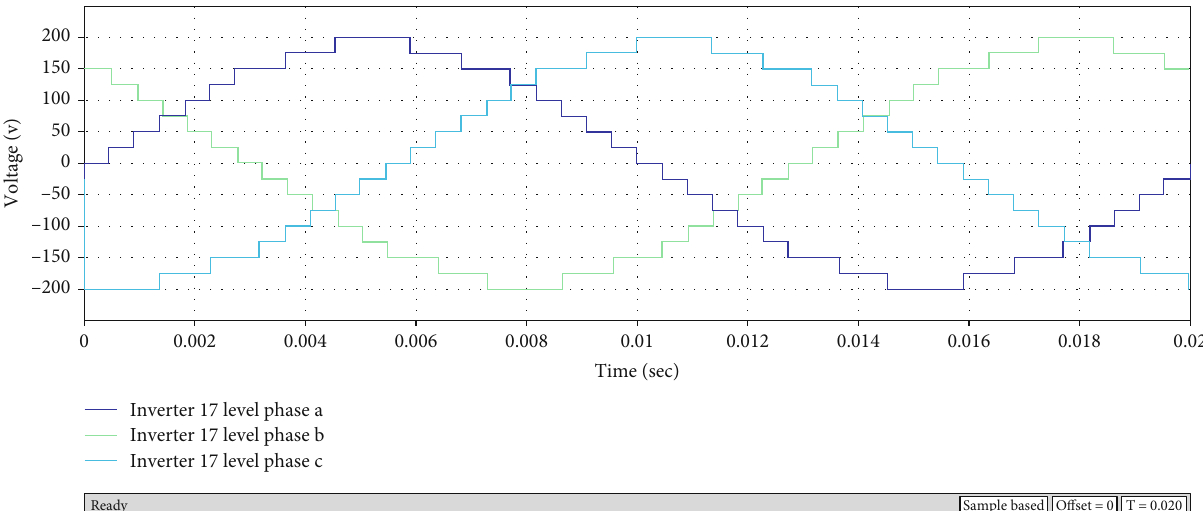
Figure 35: 3-phase MLI output with t = 0 : 02 .